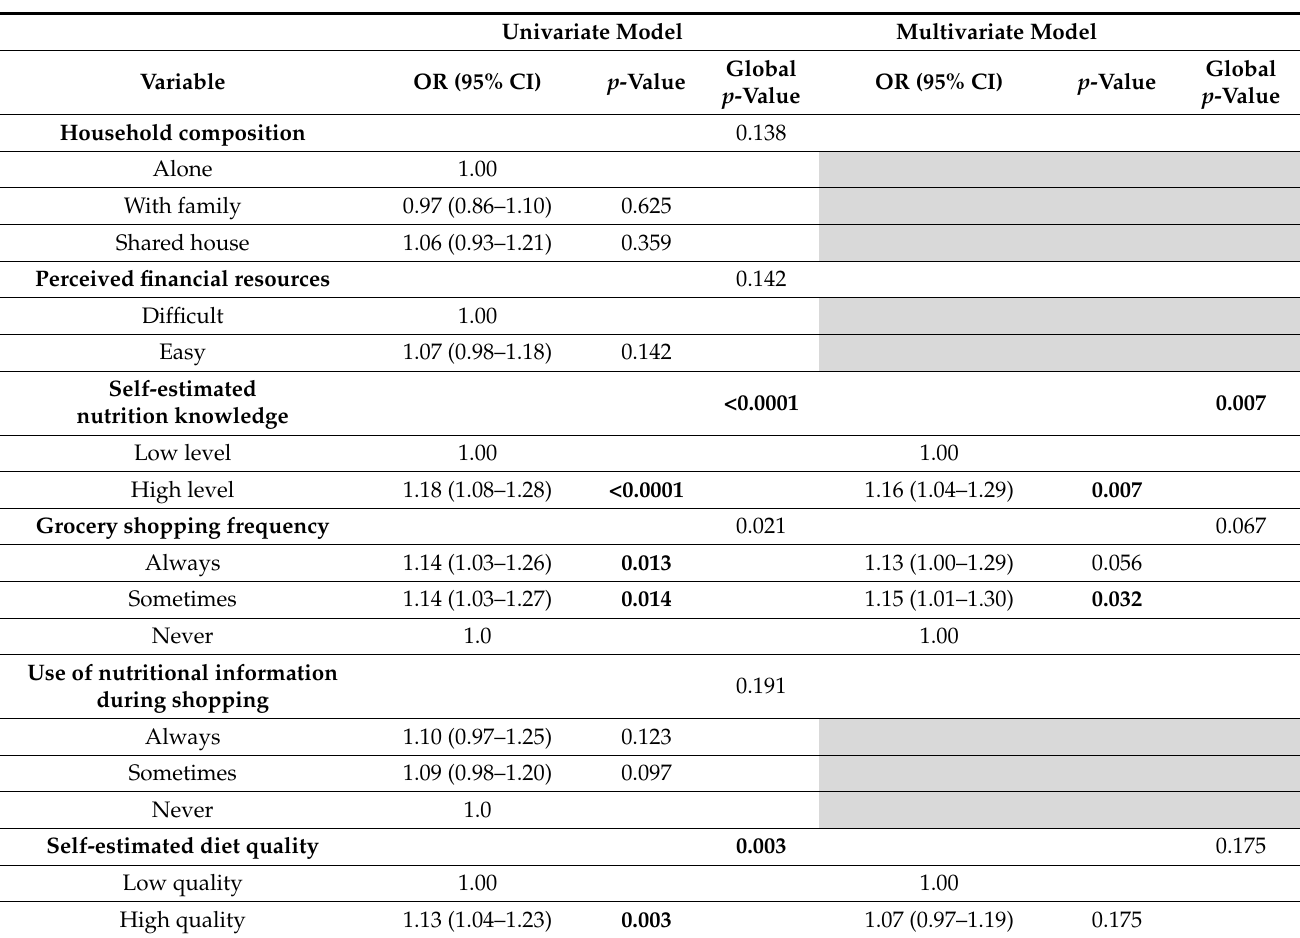
Table 2. Cont . Univariate Model Multivariate